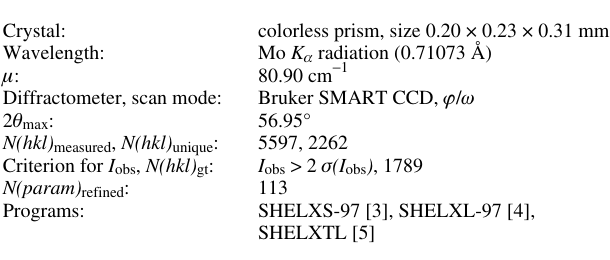
Table 1. Data collection and handling.